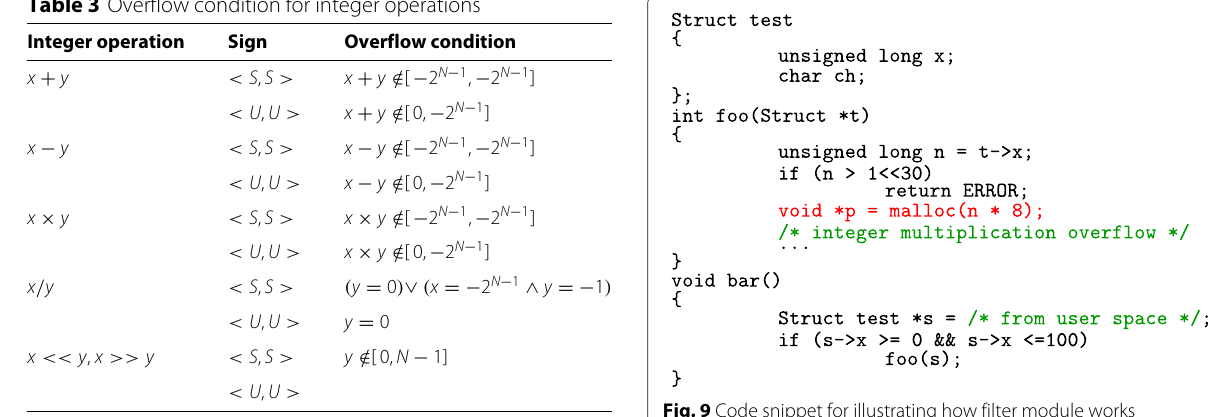
The overflow condition for the argument used in mal- loc is n > MAX / 8 . In foo, the malloc operation will